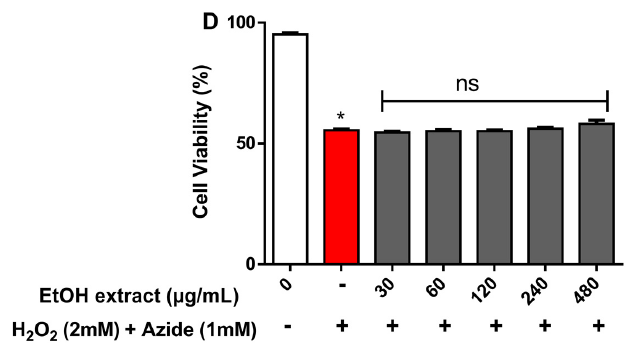
Figure 6. Effect of R. echinus leaves extracts on human leukocytes in the absence ( A , B ) and presence ( C , D ) of H 2 O 2 (2 mM) + Azide (1 mM). The signs ( − ) and (+) indicate the absence and presence of the mixture H 2 O 2 (2 mM) + Azide (1 mM), respectively. Results are expressed as percentage of control. Values are the means of n = 3 independent experiments performed in triplicate ± SEM. *: p < 0.05 vs. control.